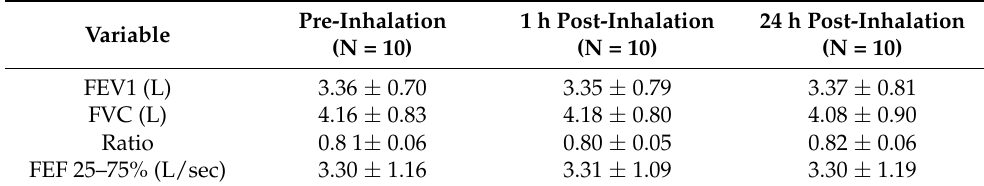
Table 5. Baseline, 1 h, and 24 h post-inhalation spirometry values with TAC-LAC dry powder for inhalation (3 mg TAC/dose).